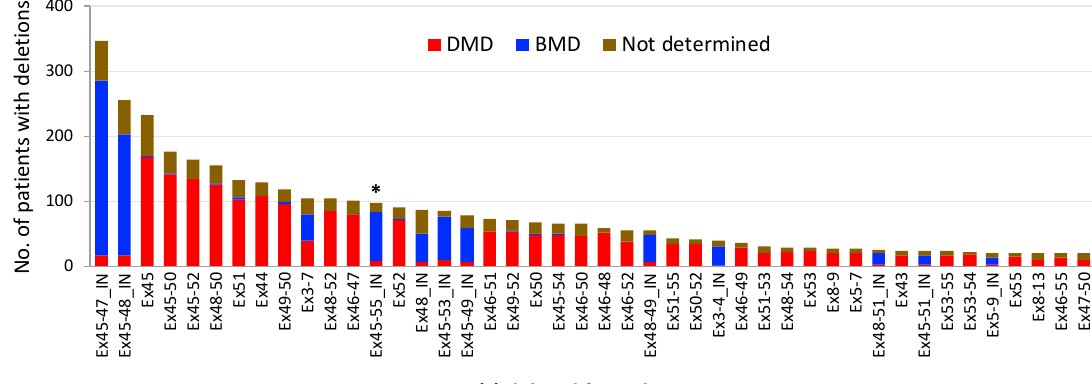
Figure 2. The frequency of large deletion mutations ( ≥ 1 exon) and its phenotypic spectrum. A total of 4929 patients with deletions from the LOVD database (as of 22 June 2018) were used. Deletions involving 20 or more patients are shown. Note the top two mutations are in-frame deletions and exons 45–55 deletion is ranked at 13th. Asterisk, exons 45–55 deletion; “IN,” in-frame deletions (otherwise out-of-frame deletions). DMD: Duchenne muscular dystrophy; BMD: Becker muscular dystrophy.